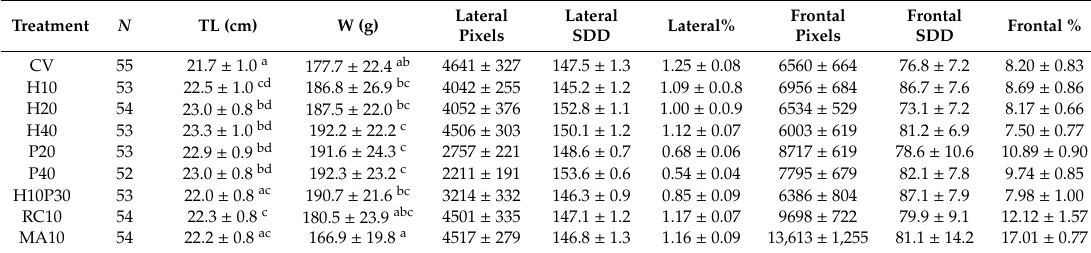
Table 3. Number of specimens (N), total length (TL), weight (W), number of lateral and frontal yellow pixels, dispersion index of lateral and frontal yellow pixels, percentage of lateral and frontal yellow pixels on the total pixel number of the image. Values are reported as the treatment mean ± S.D. Di ff erent letters (a,b,c,d) indicate significant di ff erences among treatments (Tukey test; p < 0.05); similar letters depict no significant di ff erences. CV: vegetable control; H: Hermetia illucens ; P: